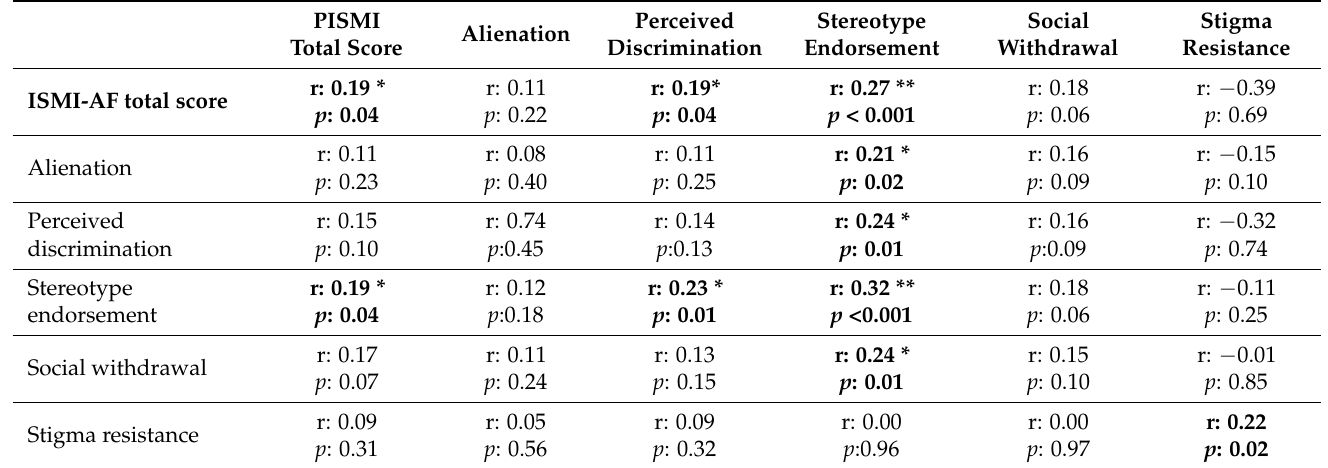
Table 3. Correlation between ISMI-AF and PISMI total and subscale scores.